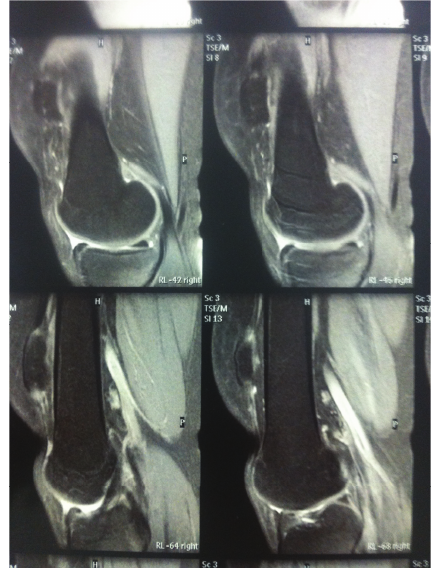
Figure 4: IRM of the knee showed a rupture of patellar tendon near the osteotendinous junction under the inferior pole of the